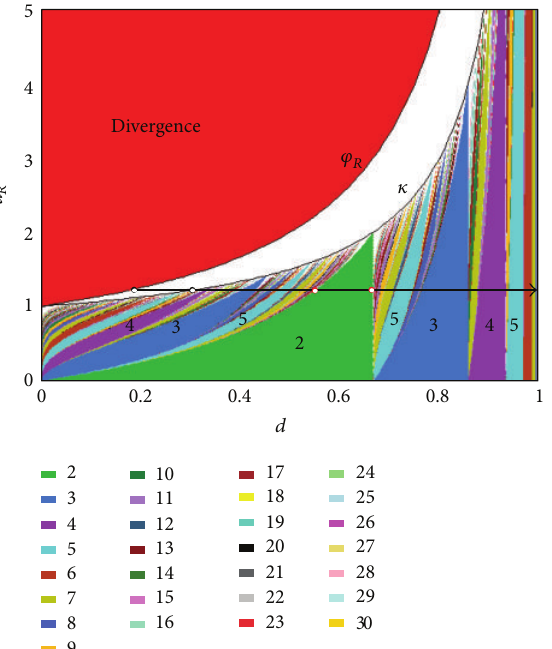
̃𝑓 in the (𝑑,𝑎 𝑅 ) -parameter